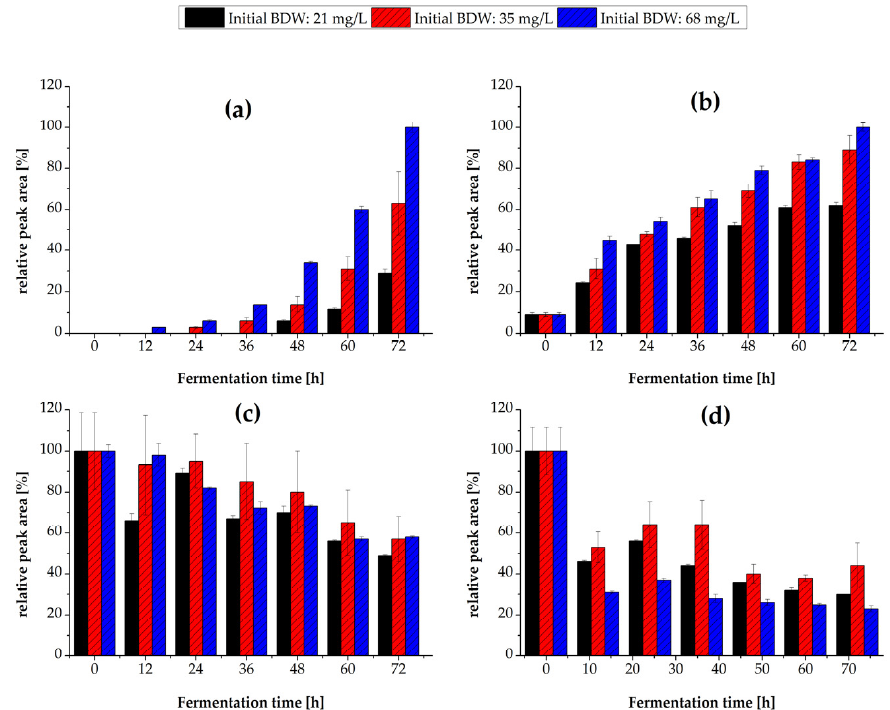
Figure 7. Production of ( a ) methyl ‐ 2 ‐ methylbutanoate, ( b ) 2 ‐ phenylethanol, and degradation of ( c ) ß ‐ damascenone and ( d ) methional by shiitake under different inoculum concentrations. BDW: biomass dry weight. Error bars are standard errors of the mean for two samples.